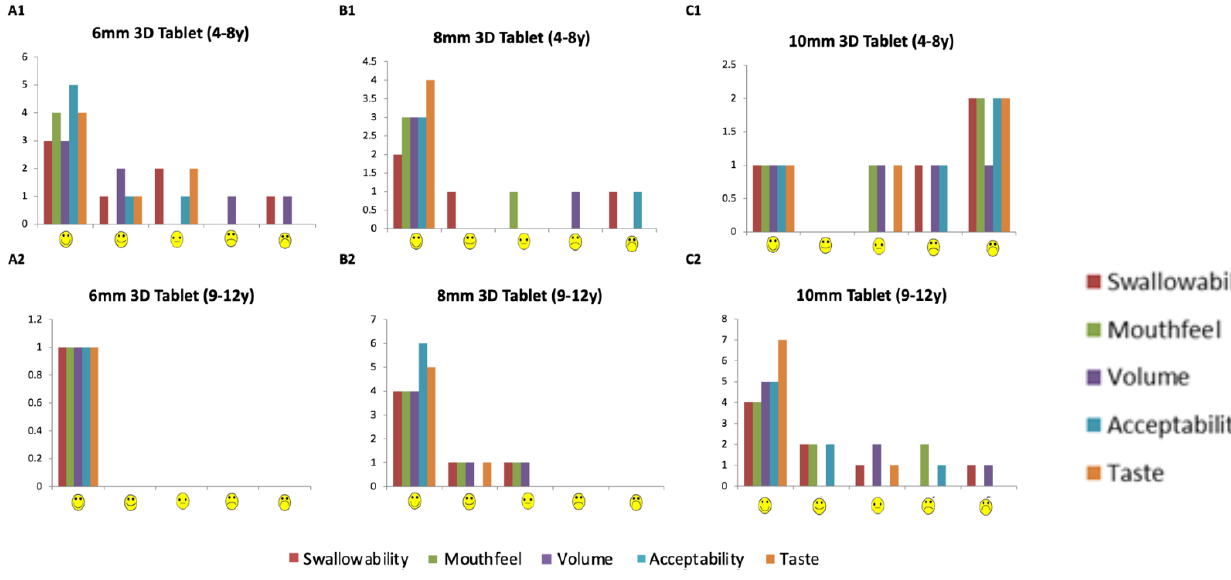
Figure 5. Overall acceptability of a 3D printed tablet. Distribution of reporting using a hedonic scale for the overall accept- ability of a 3D printed tablet.